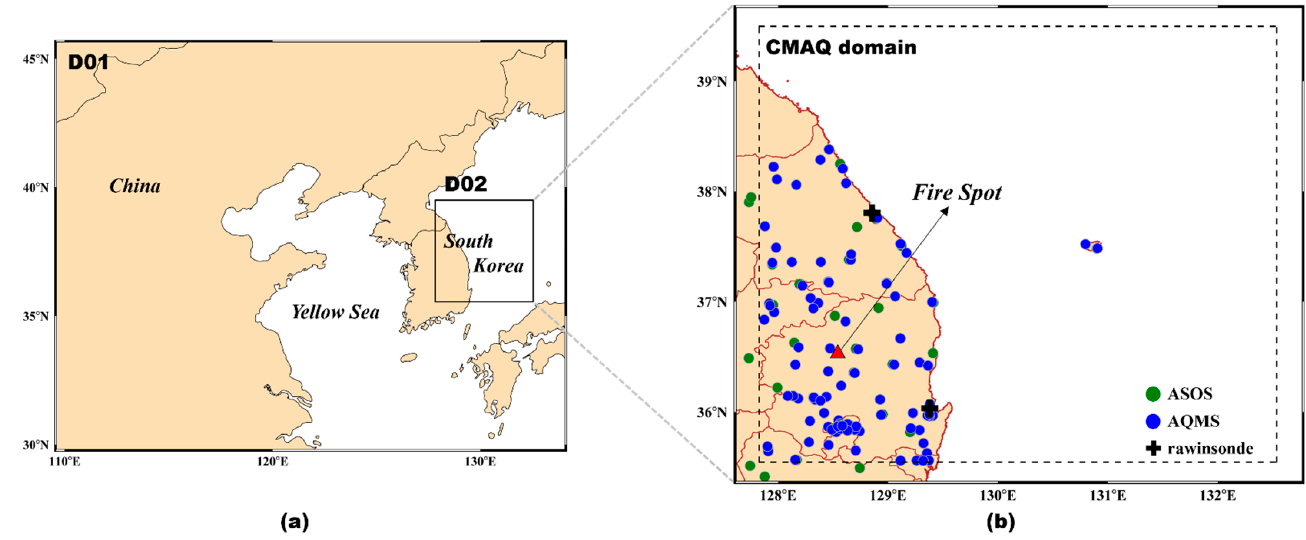
Figure 1. ( a ) Domain of CMAQ including East Asia (D01) and Andong, Gyeongsangbuk-do, South Korea (D02). ( b ) Distribution of wildfire sources (red triangles), automated synoptic observing systems (ASOS; green circles), air quality monitoring systems (AQMS; blue circles), and rawinsonde (black plus) located in D02.